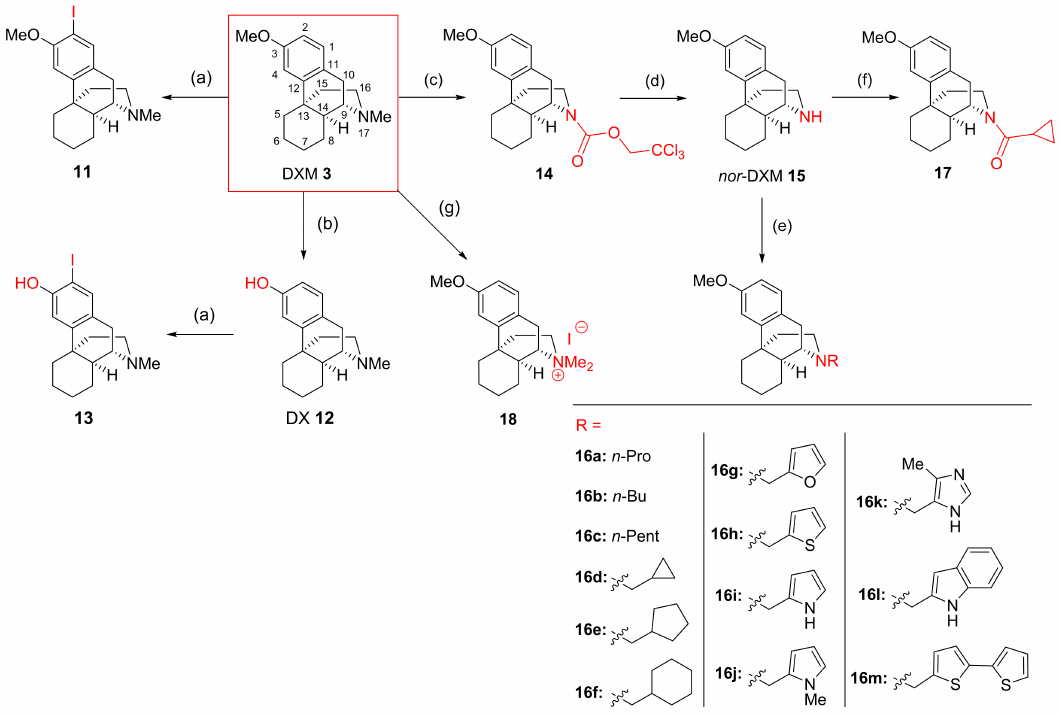
Figure 4. Semisynthetic access to DXM derivatives 11 – 18 for SAR generation (morphine number- ing). (a) NIS (1.15 eq), p -TsOH (1.8 eq) (91% 11 , 87% 13 ); (b) HBr 48%, reflux overnight (91%); (c) 2 (cid:48) ,2 (cid:48) ,2 (cid:48) -trichloroethylchloroformate (1.1 eq), toluene, reflux, 2 h (92%); (d) Zn powder (3